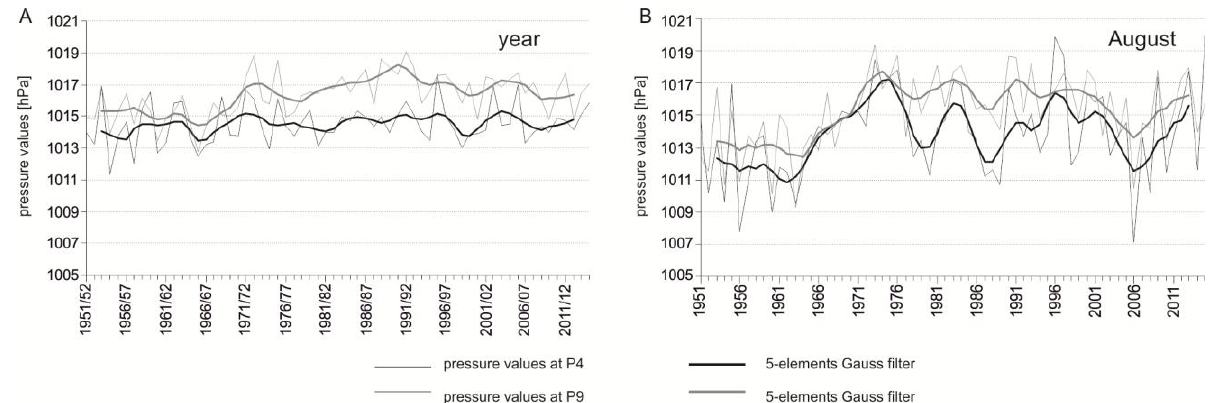
Fig. 3. Long-term variability of annual (A) and August (B) air pressure values at selected grid points in the period